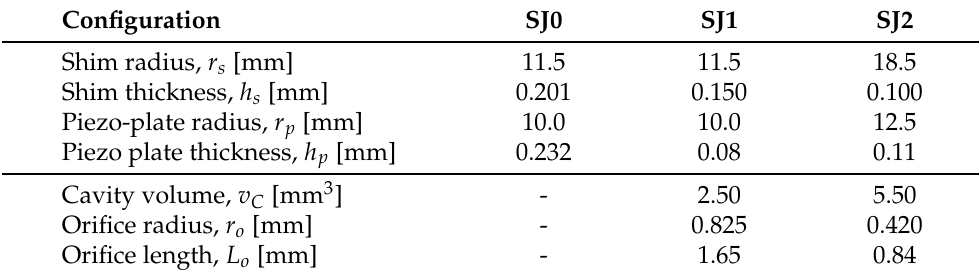
Table 3. Geometrical specifications of three synthetic jet configurations extracted from [20]. Configu- ration SJ0 is corresponding to the stand-alone actuation test; SJ1 and SJ2 are case 1 and case 2 in the cited work,